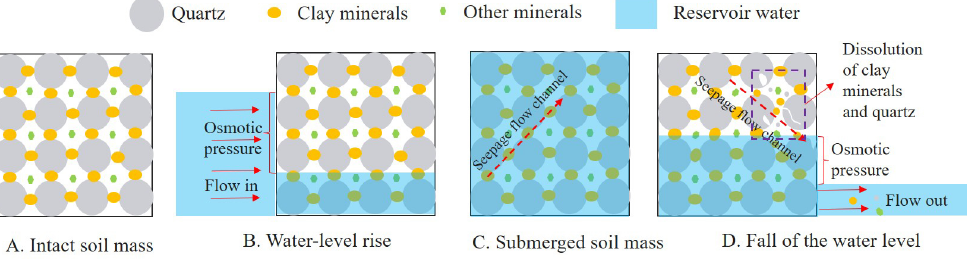
Figure 10. Generalized diagram of soil degradation of water level